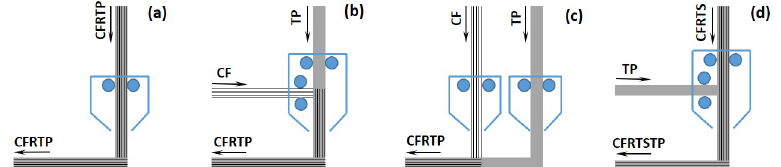
Figure 2. Methods for continuous fiber-reinforced polymer (CFRP) fused filament fabrication (FFF): ( a ) fibers embedded before the printer head; ( b ) fibers embedded inside of the printer head; ( c )